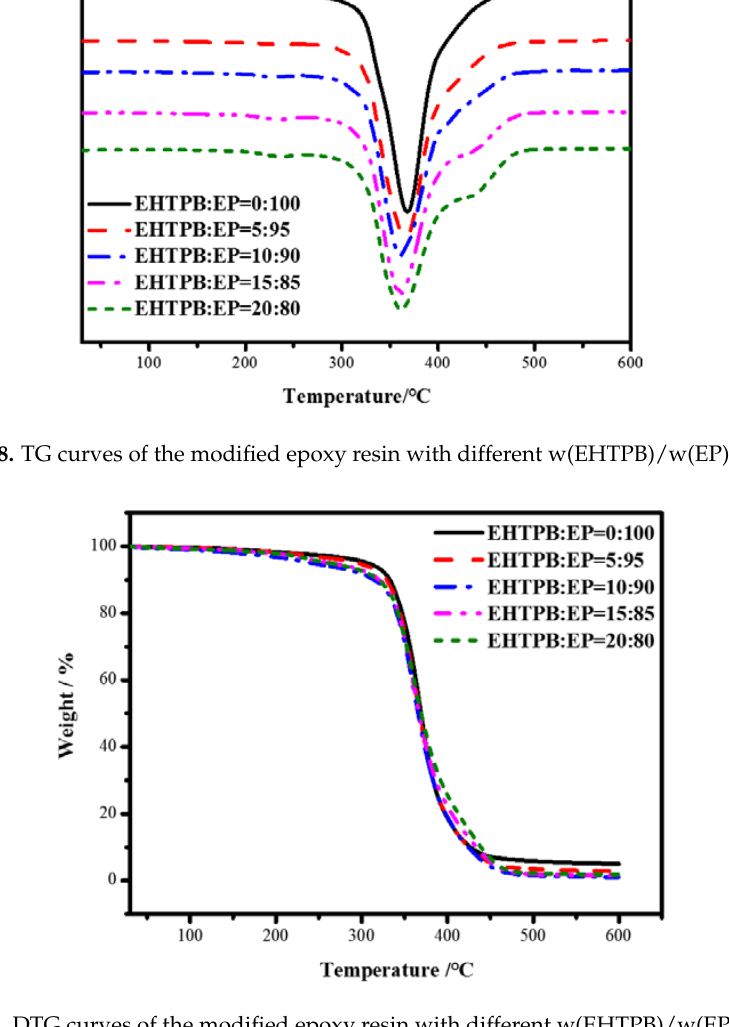
Figure 9. DTG curves of the modified epoxy resin with different w(EHTPB)/w(EP) ratios.